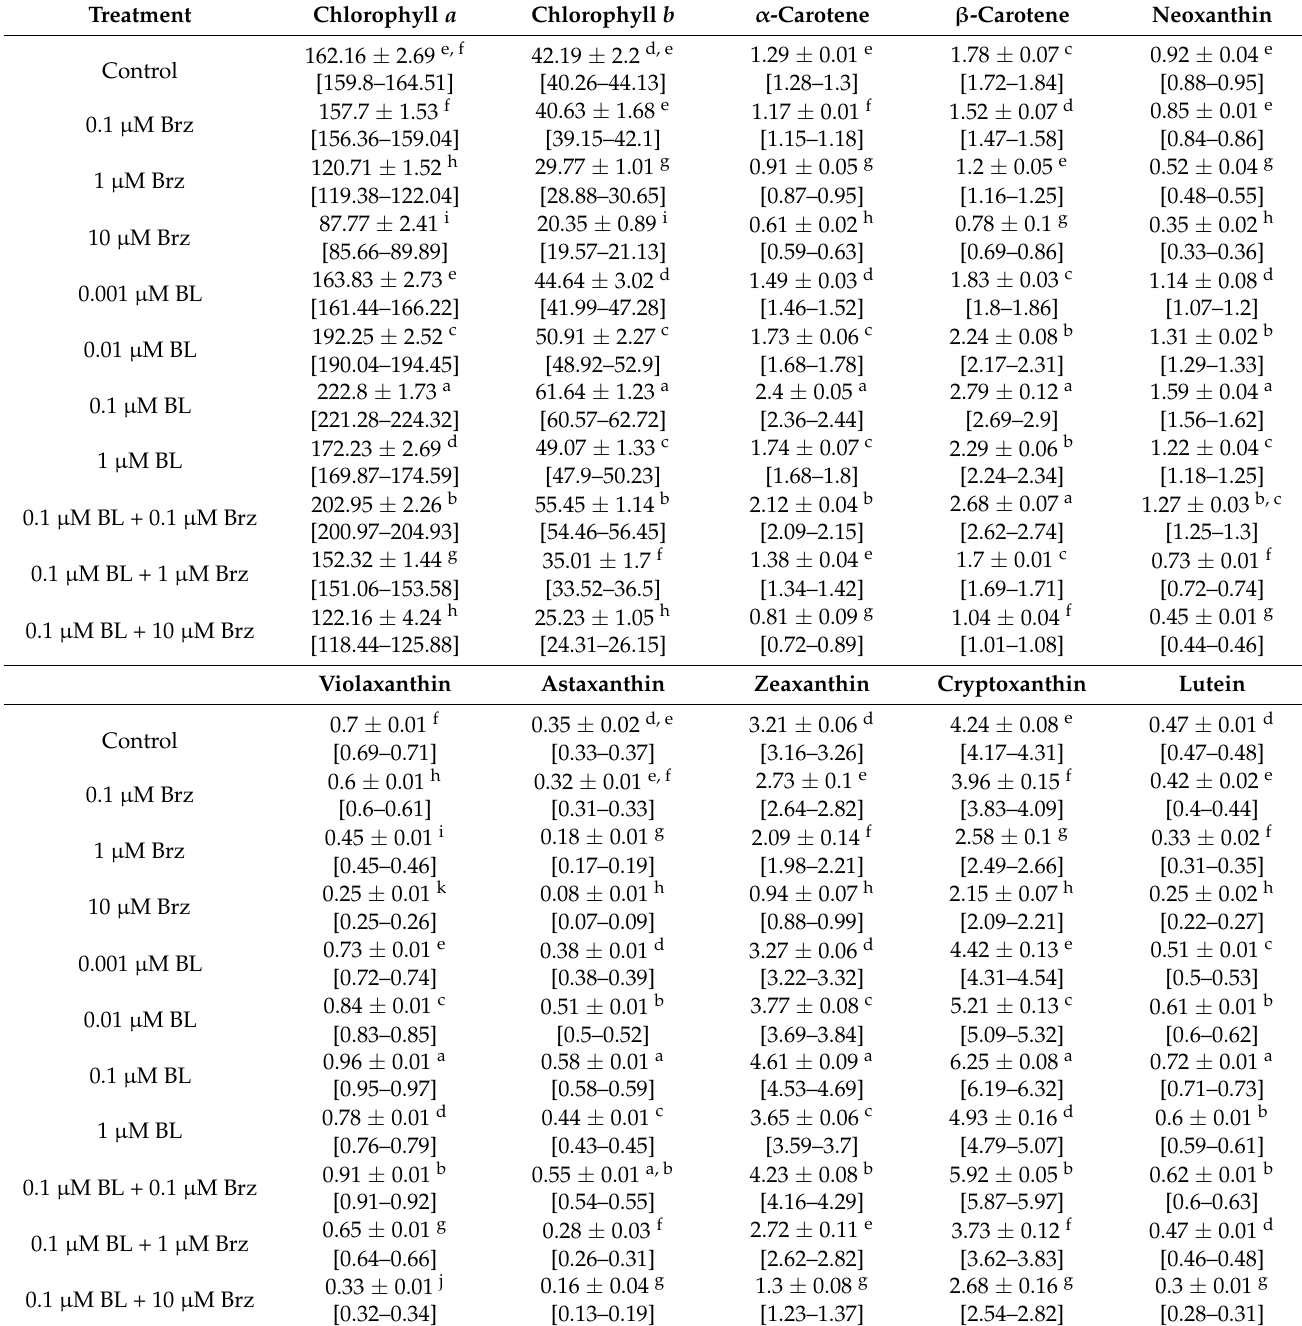
Table 2. The endogenous level of chlorophylls, carotenes, and xanthophylls ( µ g/g fresh weight) in W. arrhiza treated with Brz and/or BL after 7 days of cultivation. Data present the mean ( n = 5) ± standard deviation. The range in square brackets corresponds to the 95% confidence interval of the mean. Means with the same letters are not significantly different ( p ≥ 0.05) according to Tukey’s post hoc